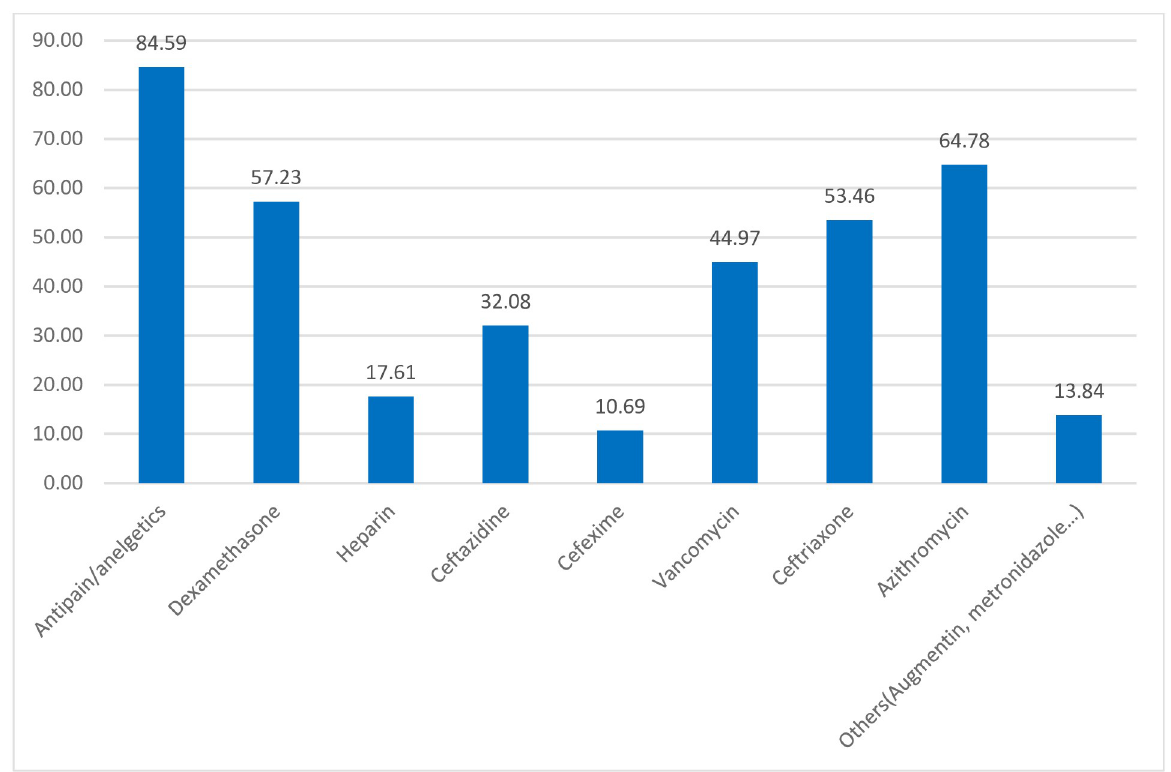
Fig 2. Percentage distribution of types of drugs used for treating severe COVID-19 patients admitted at WURH, 2021.